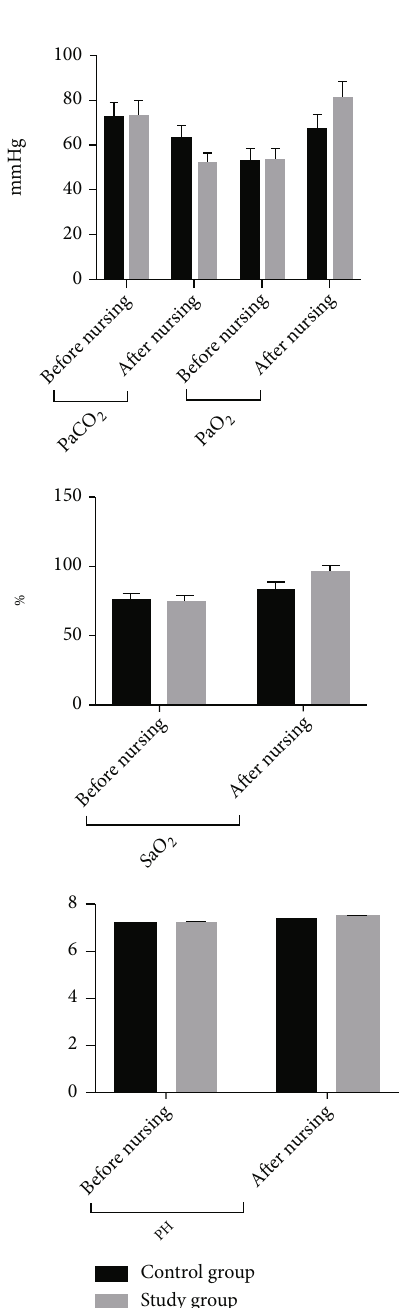
Figure 2: Histogram of blood gas comparison between two groups before and after patient